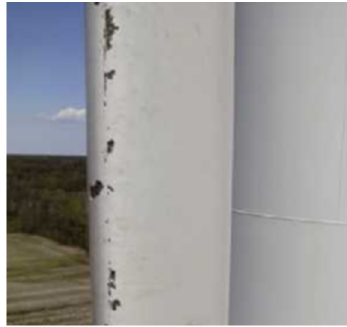
Figure 2. Photo of the leading edge erosion [29].